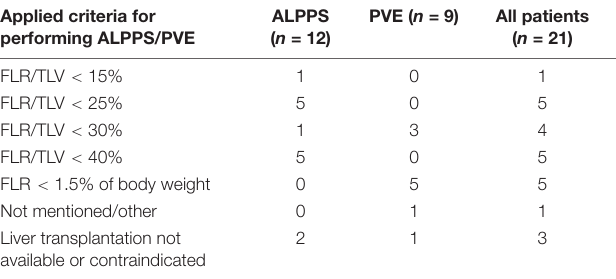
FIGURE 2 | FLR of individual patients before stage 1 and before stage 2 of